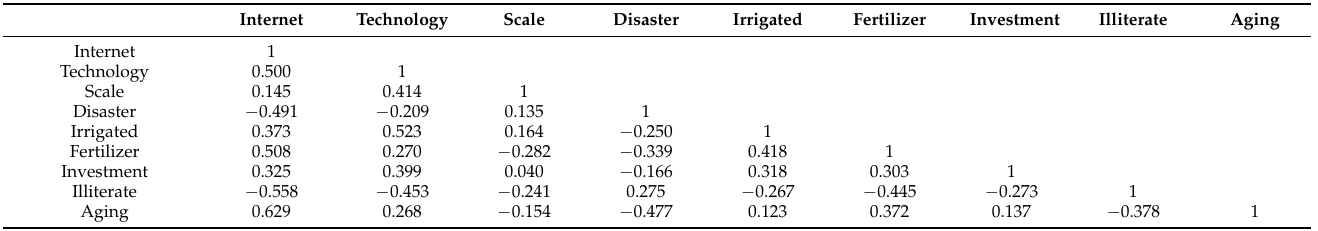
Table 2. Correlation